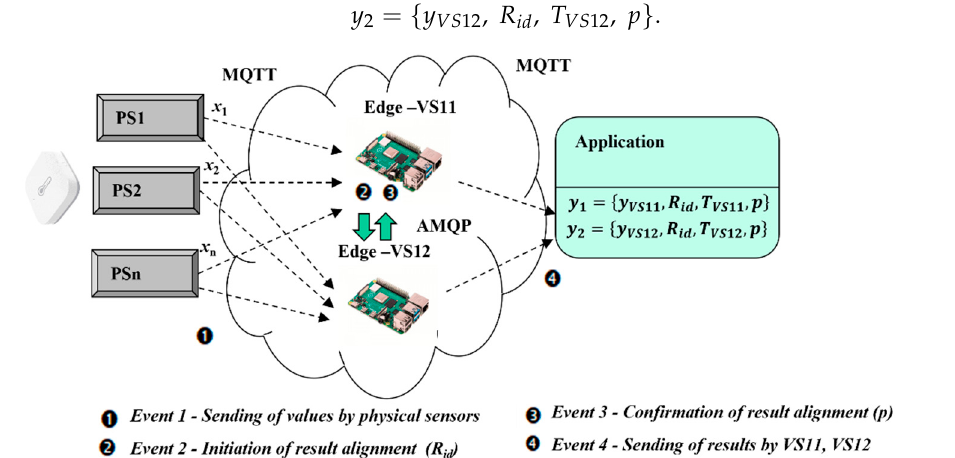
Figure 7. Virtual redundant sensor model with duplexing approach.